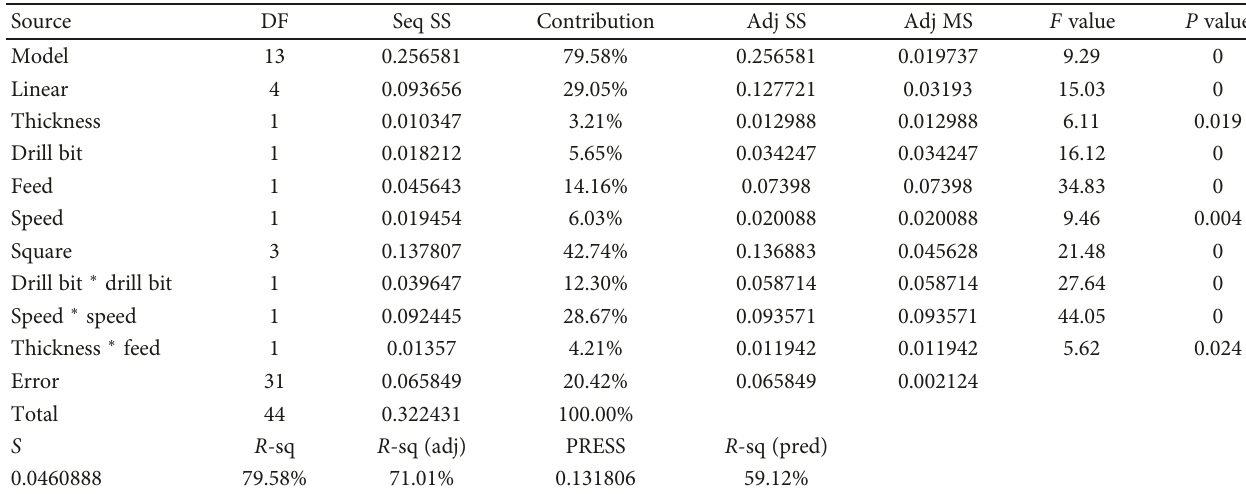
Table 4: ANOVA analysis for